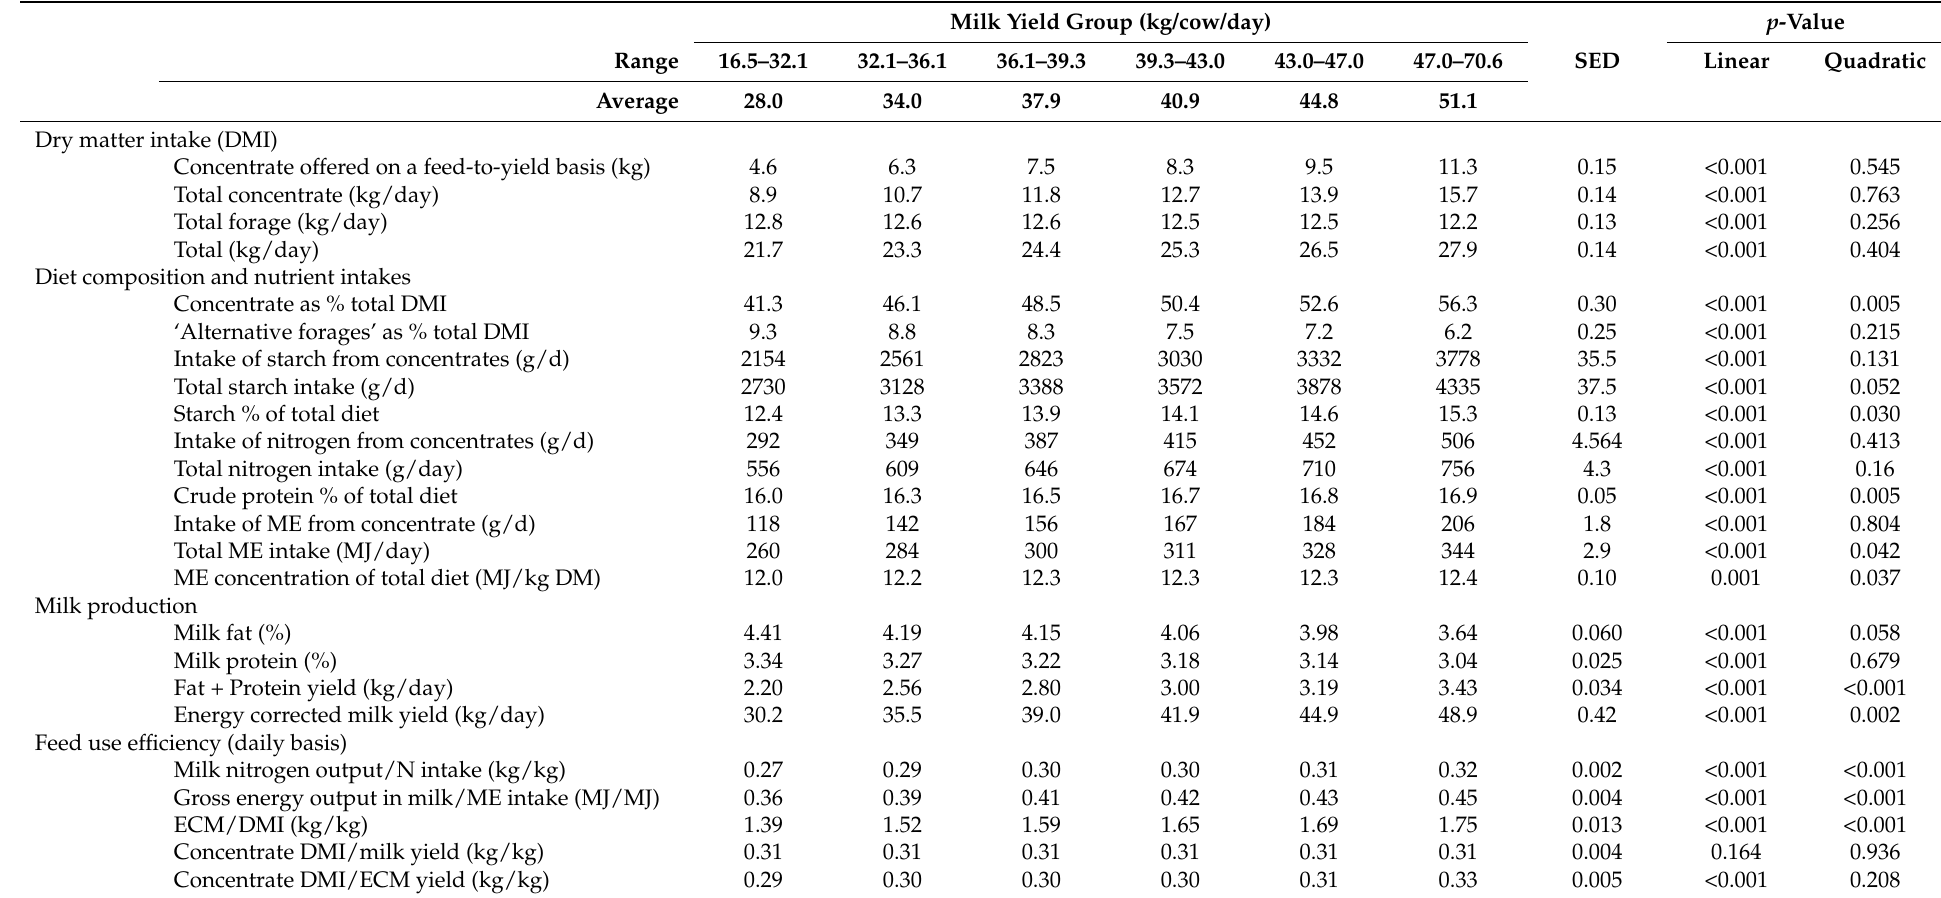
Table 5. Dry matter intakes, nutrient intakes and diet composition, milk production, and efficiency values within each milk yield group for fourth and higher lactation